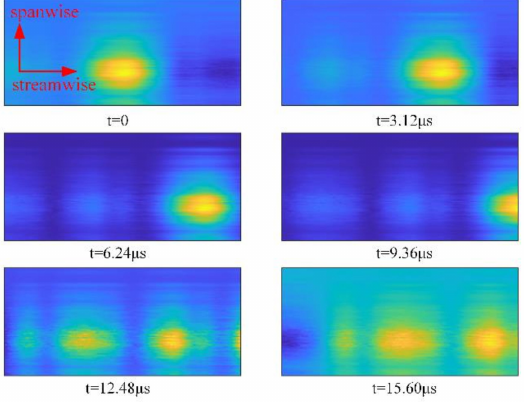
Figure 10. Transient OPDs at different